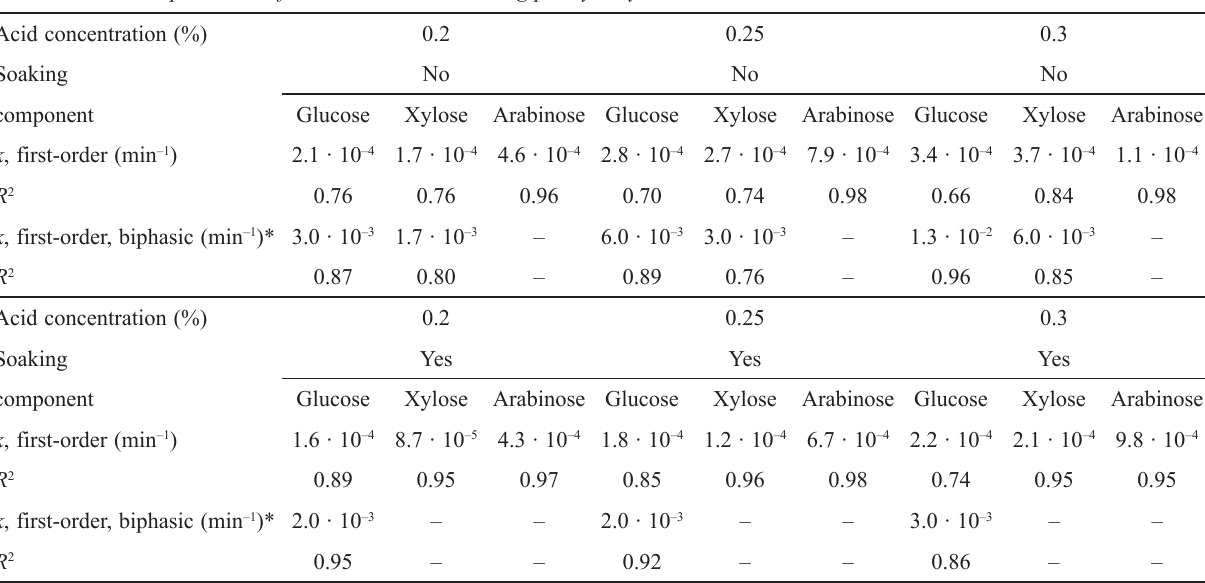
Table 5 – Model parameters for the arabinose removing pre-hydrolyses Acid concentration (%)